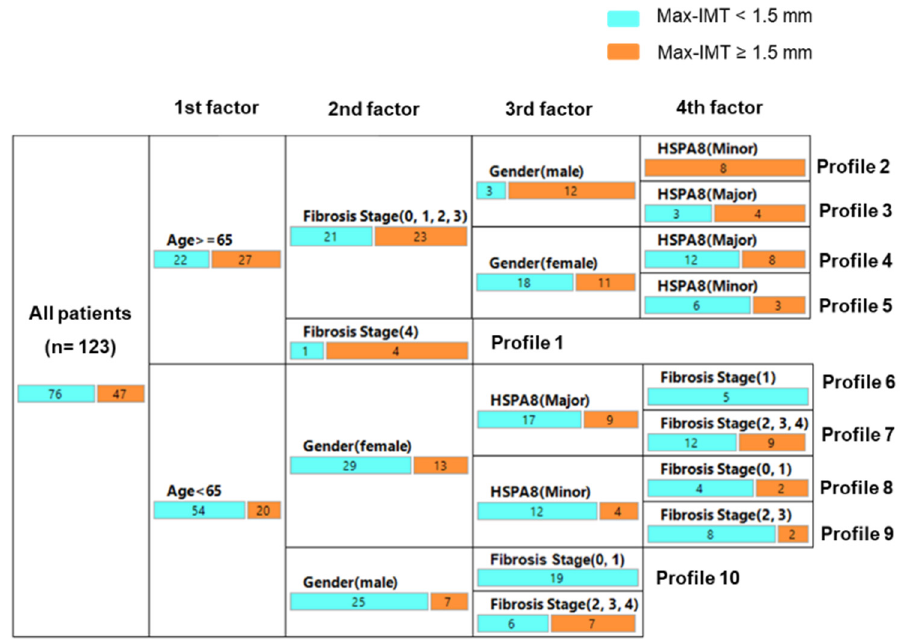
Figure 5. Decision-tree analysis to identify the factors associated with significant Max-IMT. Max-IMT, maximum intima–media thickness.